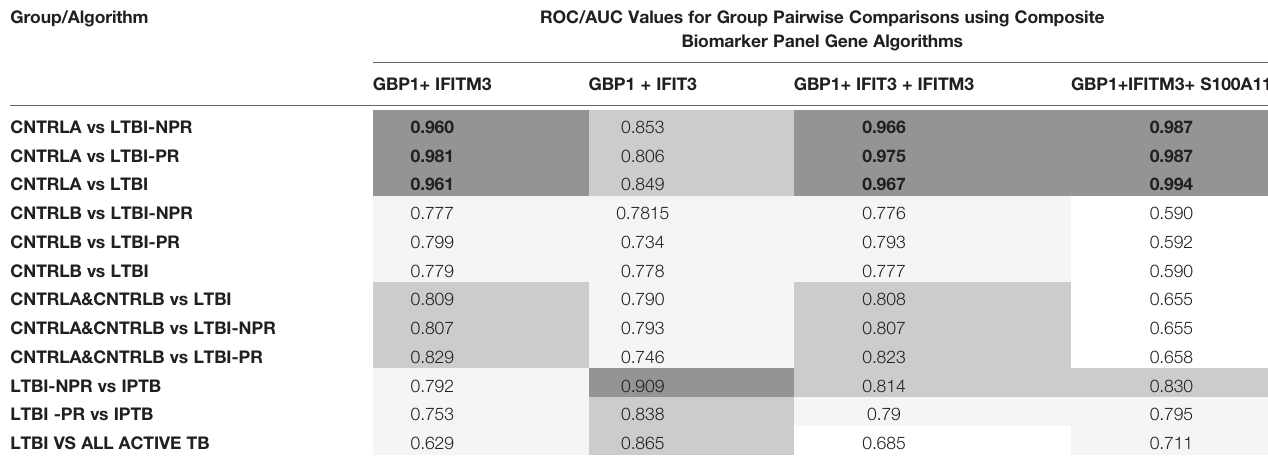
TABLE 2 | Summary of AUC ROC values for control, latent and combined ATB group pairwise comparisons using simple, composite arithmetic algorithms.